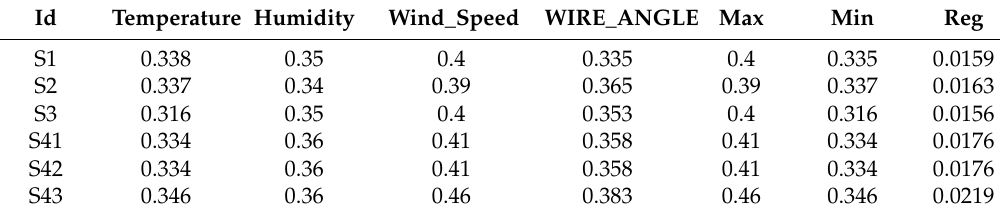
Table 7. S 4 .TB-qdatas table.